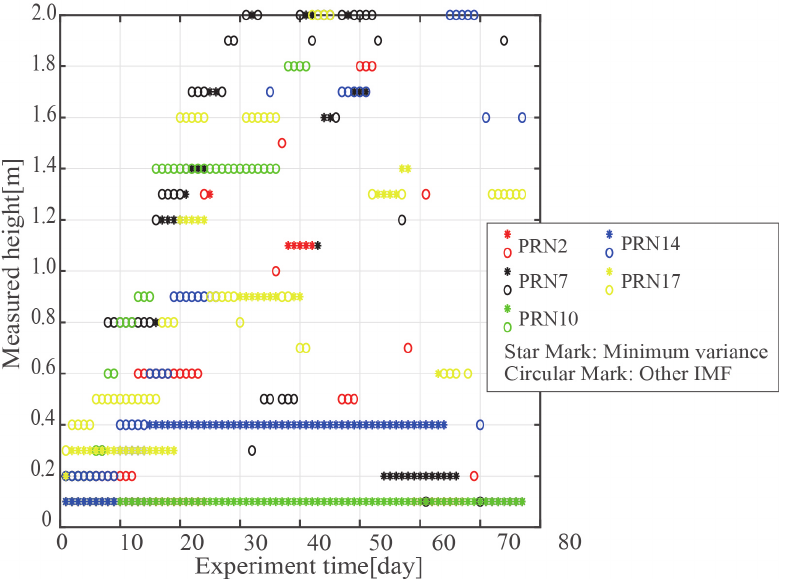
Figure 8. Time distribution of the retrieved height intervals from different IMFs.